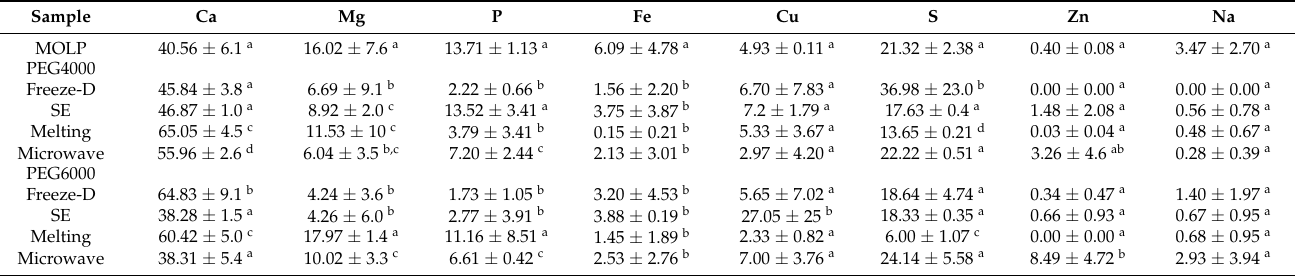
Table 2. The elemental composition of the MOLP and solid-dispersed